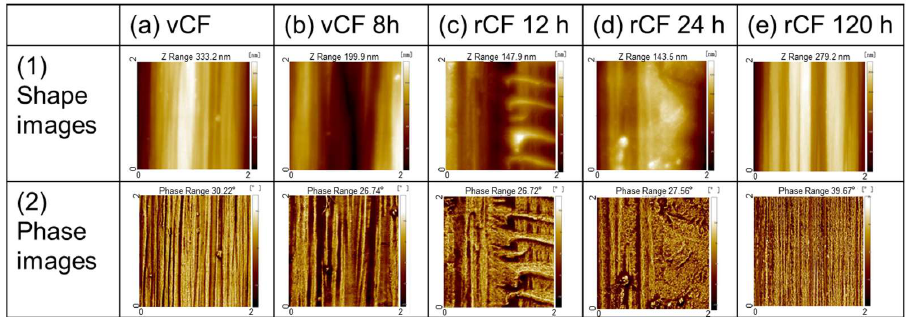
Figure A5. AFM shape images and phase images of vCF and rCF surface taken from the observation area 2 μm × 2 μm.